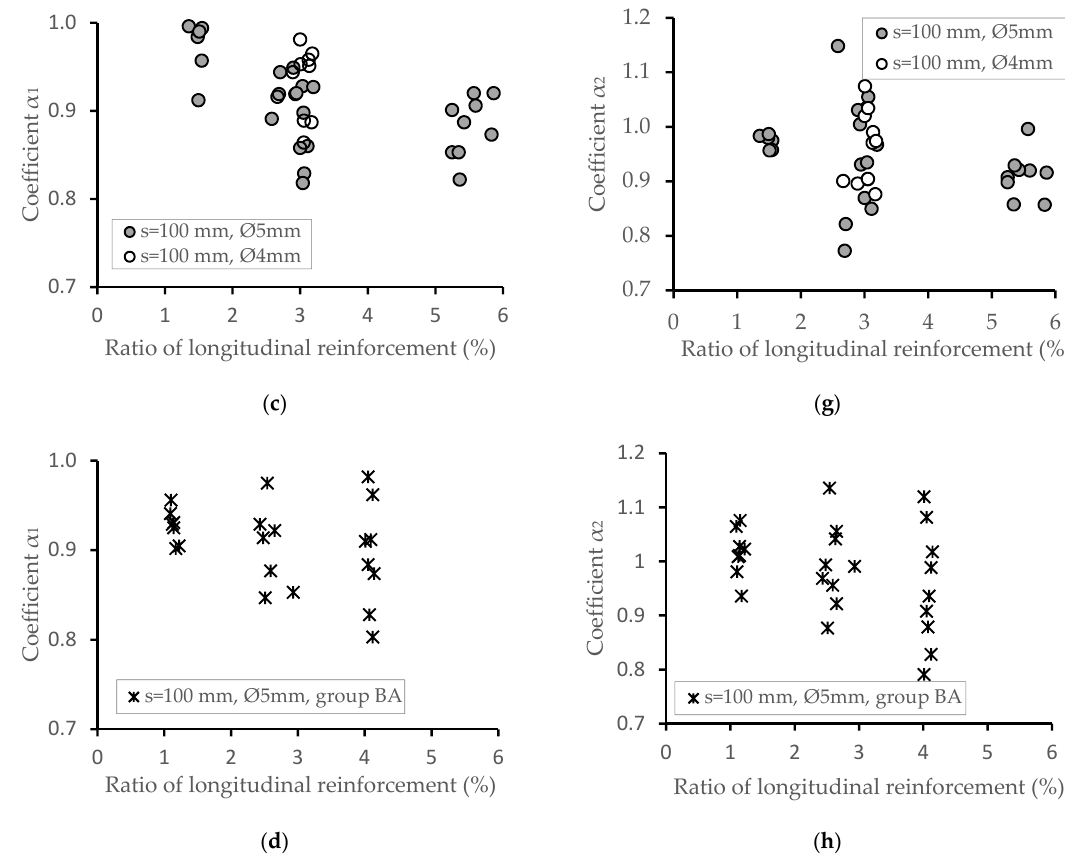
Figure 7. Coefficients α 1 (a,b,c,d) and α 2 (e,f,g,h) dependence on the ratio of longitudinal reinforcement µ s by different pitch of transverse reinforcement.